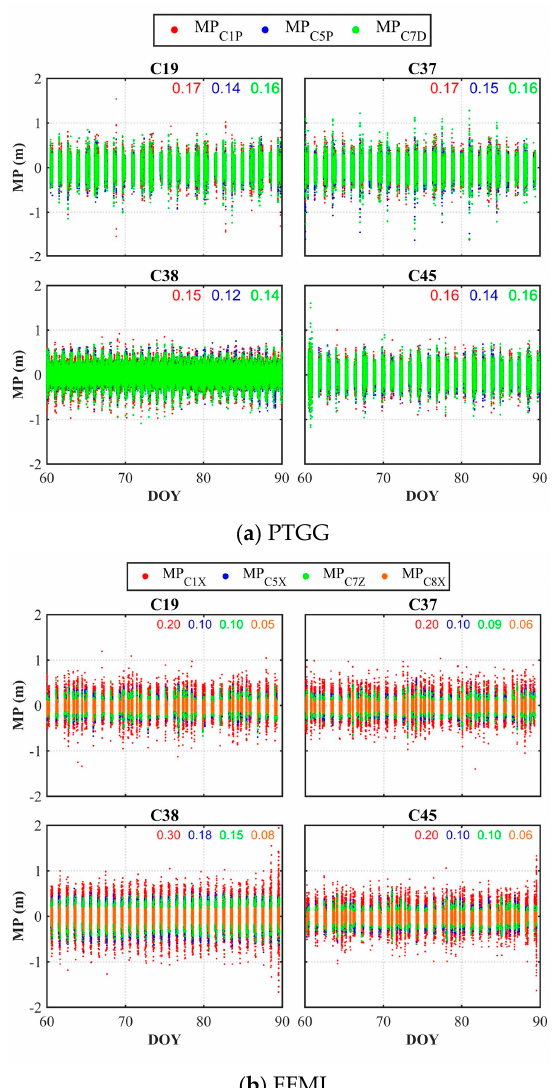
Figure 2. MP of the BDS-3 C19, C37, C38, and C45 satellites at stations PTGG ( a ) and FFMJ ( b ) during a period of 30 days.